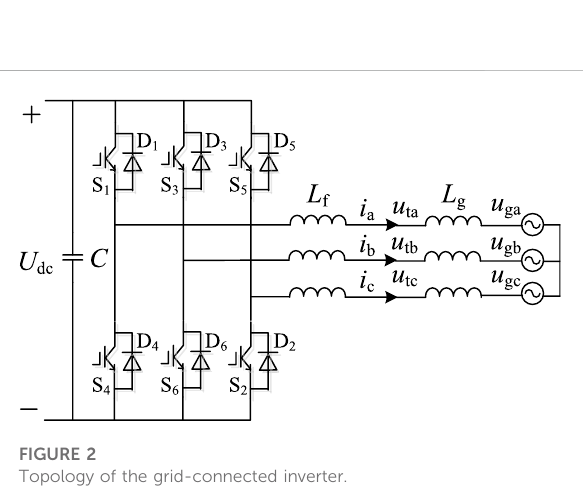
FIGURE 3 The vector control based on grid voltage orientation of the inverter.